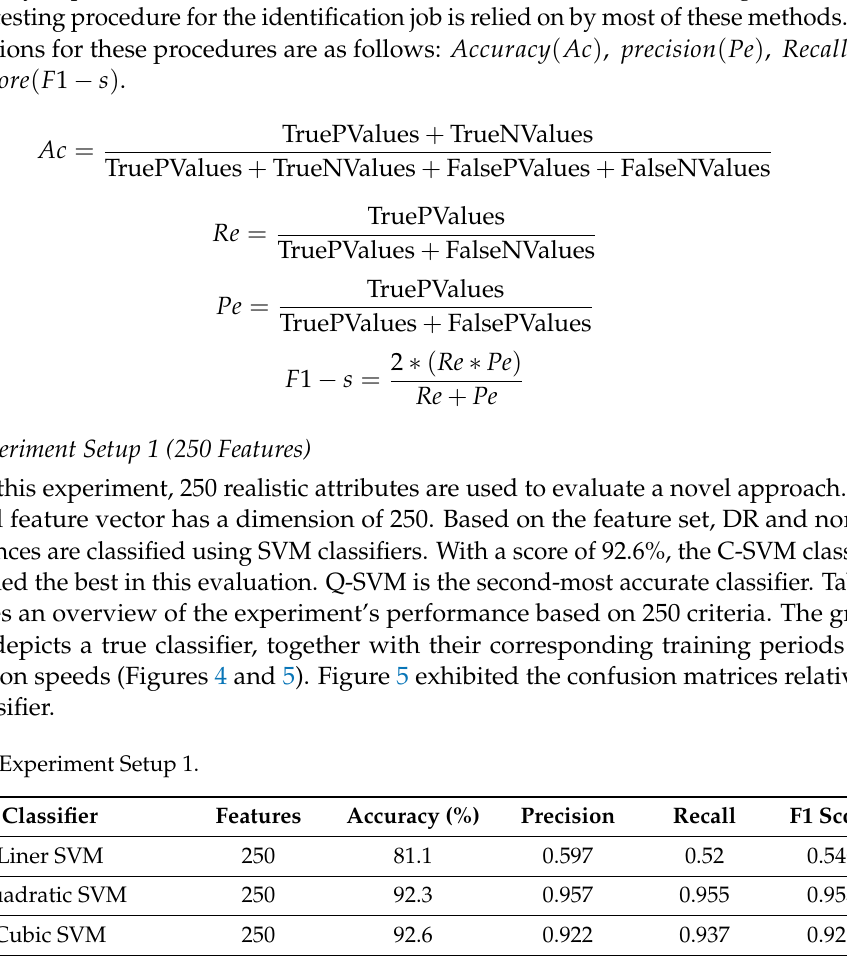
Table 1. Experiment Setup 1.